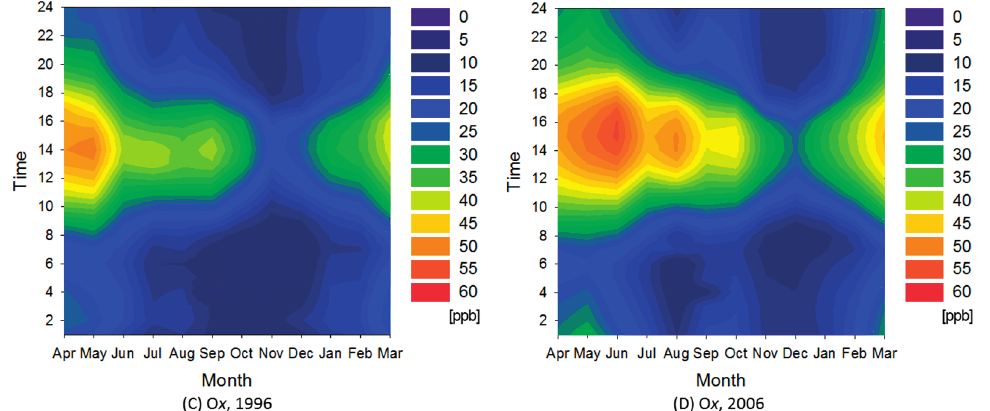
Figure 9. Contour maps for NO x and O x in 1996 and 2006.